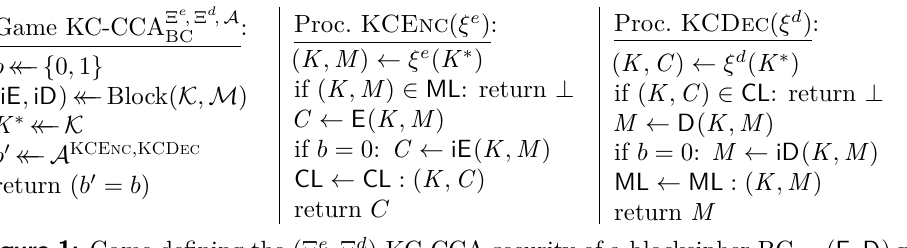
Figure 1: Game defining the (Ξ e , Ξ d )-KC-CCA security of a blockcipher BC = ( E , D )